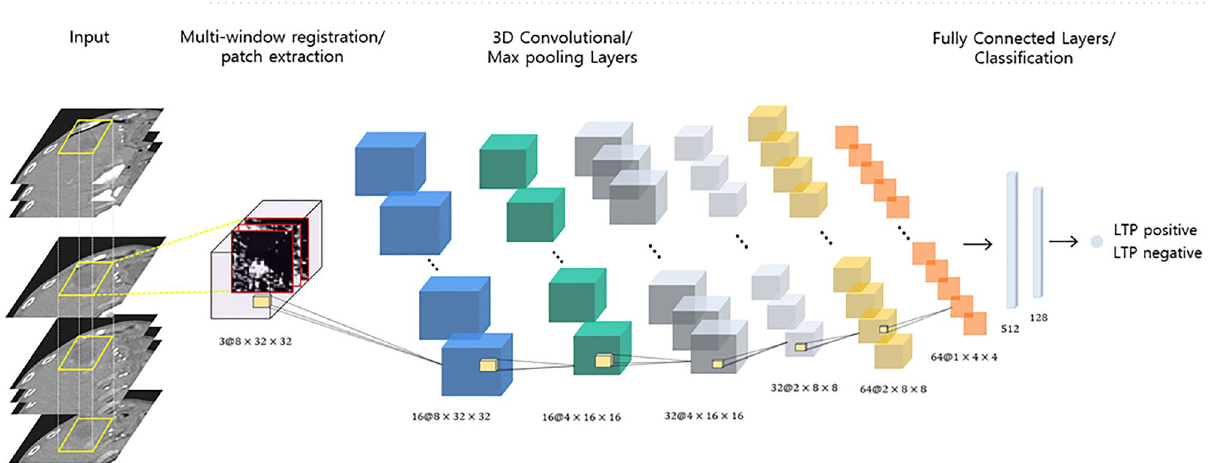
Figure 5. Schematic representation of image preprocessing/data augmentation steps and 3D-CNN model for LTP classification. The system includes a pipeline of the tumor region proposal technique.